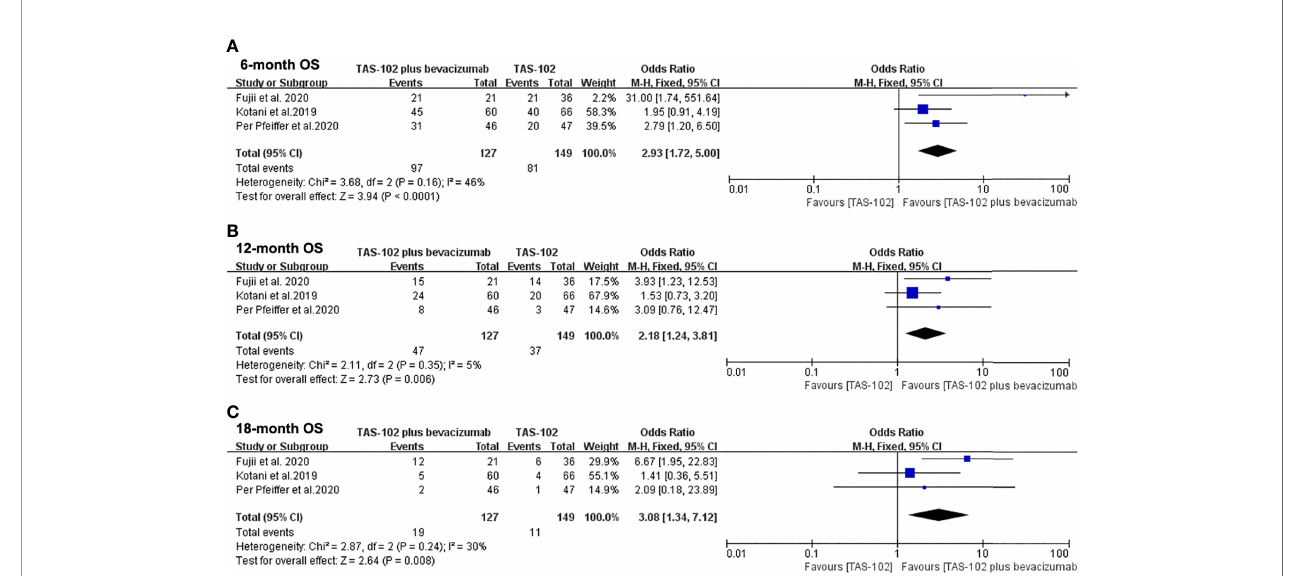
FIGURE 3 | Forest plot of pooled relative risk for overall survival from included studies. (A) 6-month overall survival. (B) 12-month overall survival. (C) 18-month overall survival. Horizontal lines represent 95% con fi dence intervals (CIs). M-H, Mantel-Haenszel; df, degrees of freedom; OS, overall